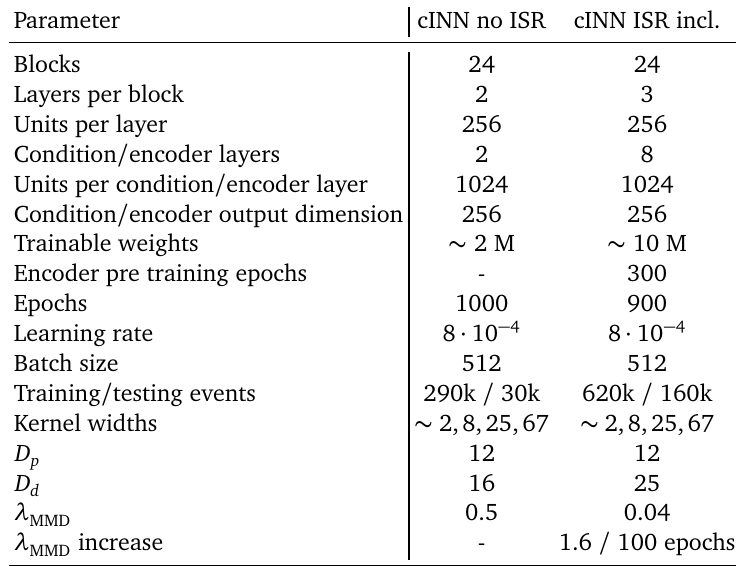
cINN setup and hyper-parameters, as implemented in P Y T ORCH (v1.2.0) [ 68 ]